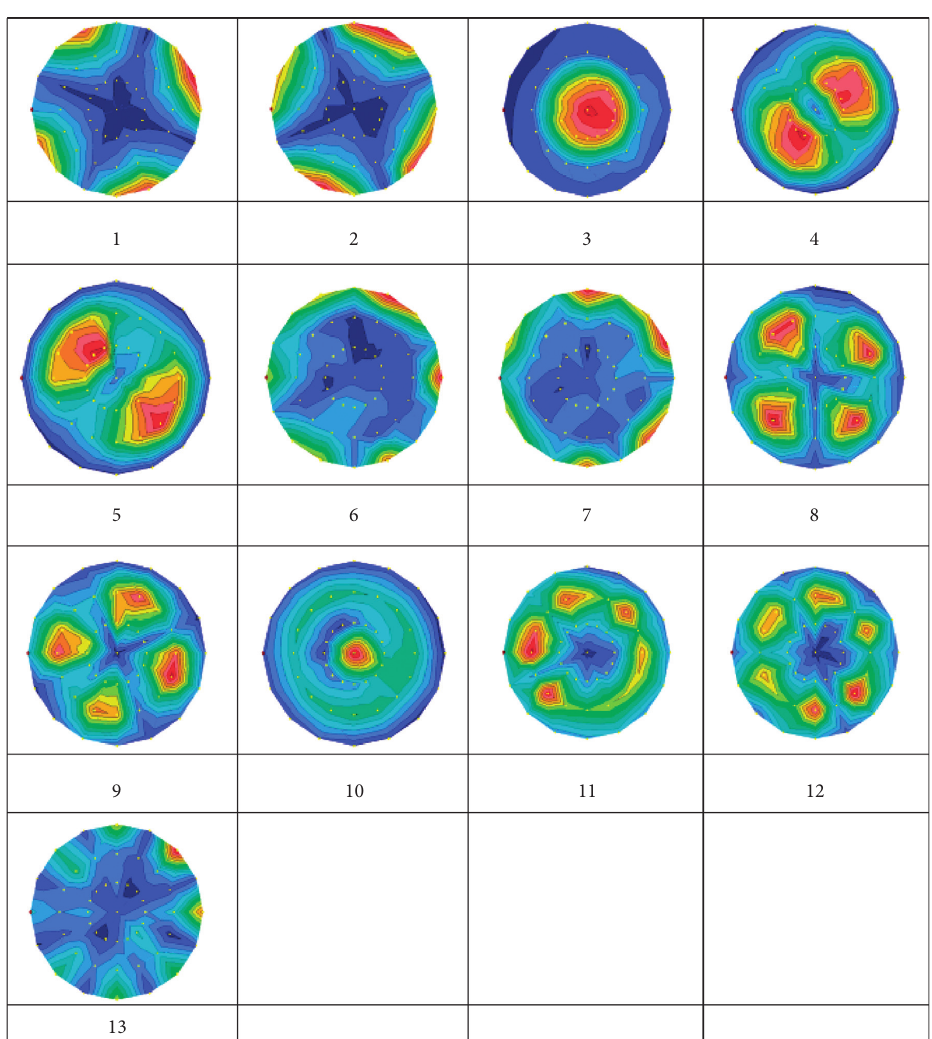
Figure 14: Vibration mode shapes from the